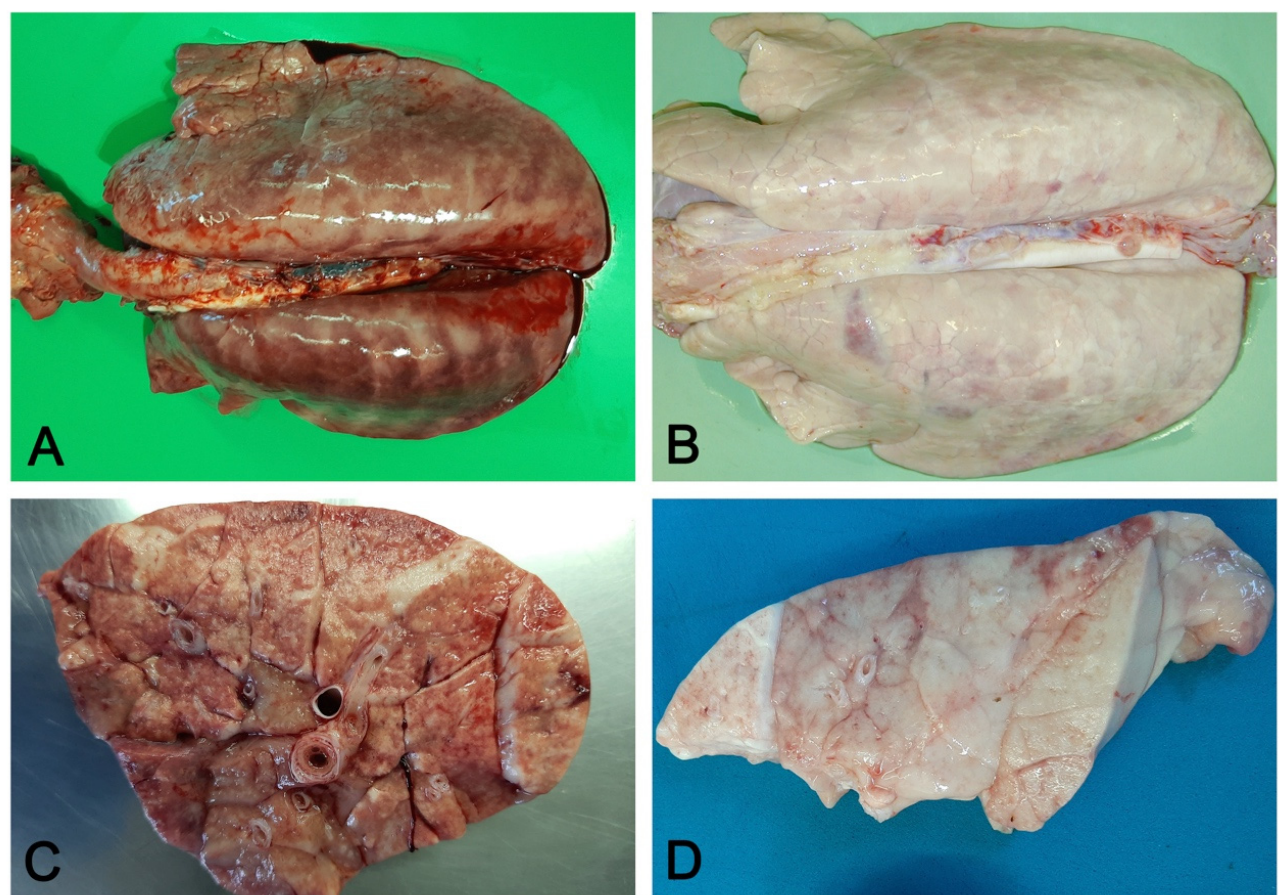
Figure 5. Interstitial pneumonia: non-collapsed lungs, with rib impressions ( A ), in acute ( A ) and chronic ( B ) interstitial pneumonia. Acute changes include diffuse hyperemia and edema of perilobular connective tissue ( C ). In chronic stages, the lung is slightly increased in consistency and colored whitish due to fibrosis ( D ).